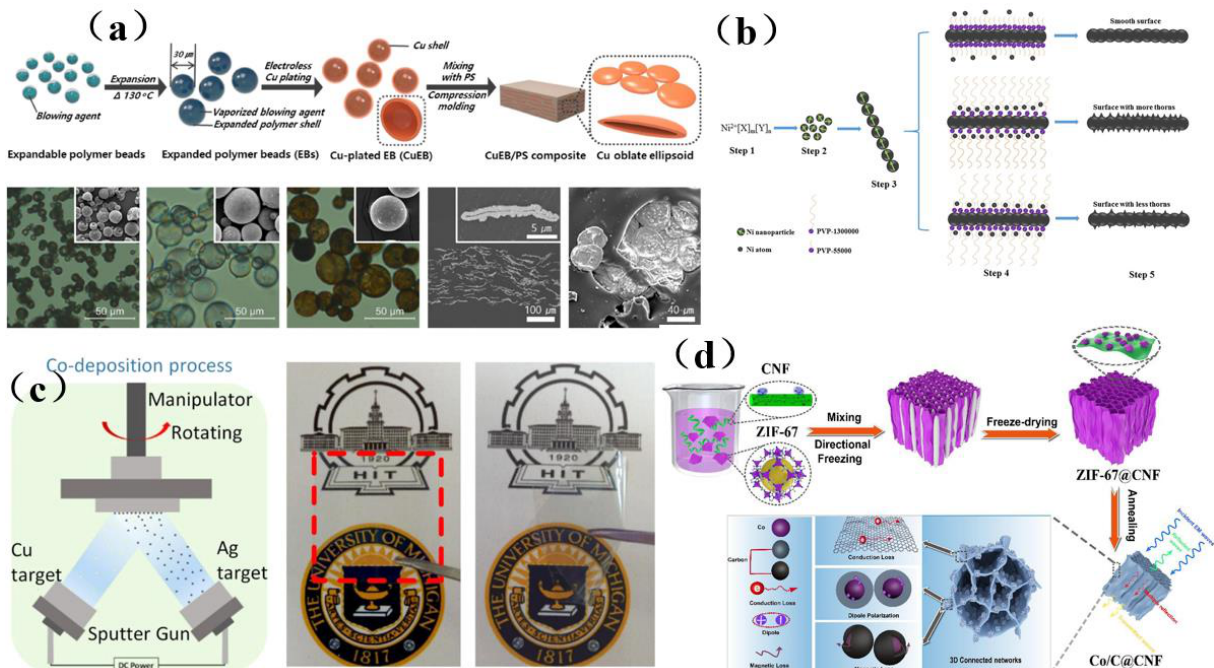
Figure 7. ( a ) Schematic diagram of shielding material comprised of polystyrene composite mem- brane containing copper oblate ellipsoid particles [103]. Copyright 2017, Elsevier. ( b ) Schematic di- agram of the PVP-regulated mechanism for the growth of NiNWs [104]. Copyright 2019, Elsevier. ( c ) Schematic diagram of co-deposition process and transparency comparison of Ag/Cu/PET trans- parent membrane for electromagnetic interference shielding [105]. Copyright 2019, American Chemical Society. ( d ) Schematic diagram depicting the fabrication of Co/C@CNF aerogel and sche-